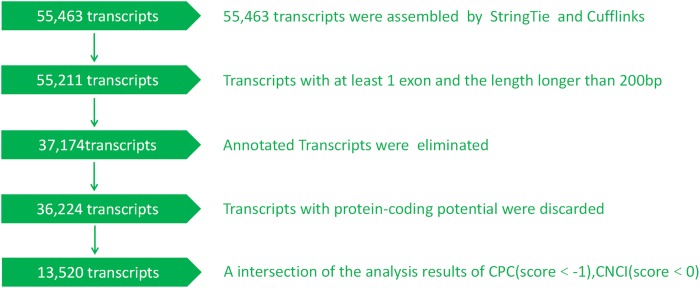
The developed pipeline for identifying putative lncRNAs.Briefly, 55,463 transcripts were assembled and 13,520 novel lncRNAs were identified.